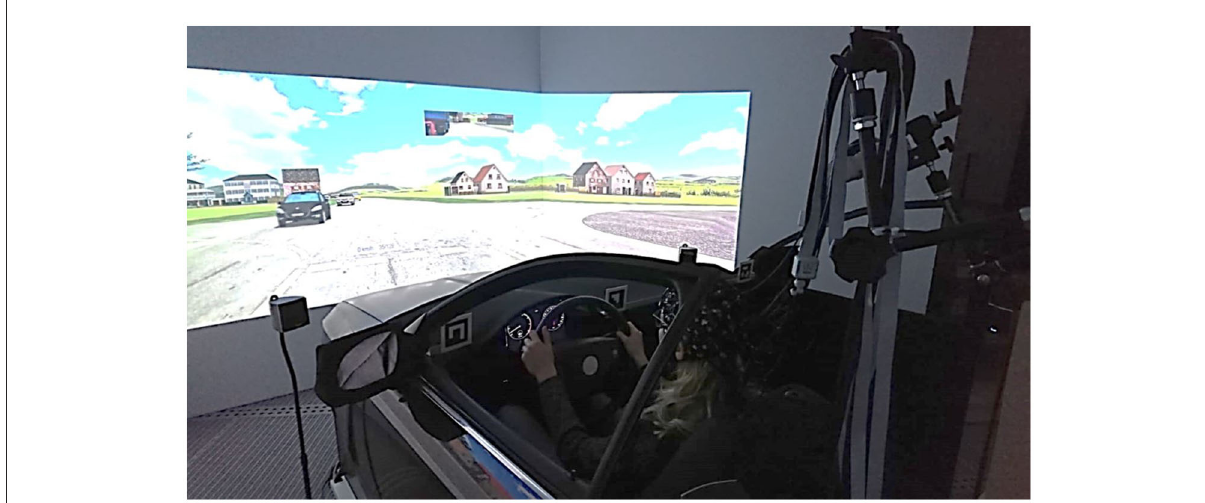
FIGURE1 Virtual reality lab driving simulator with the whole-head fNIRS system during the experiment.